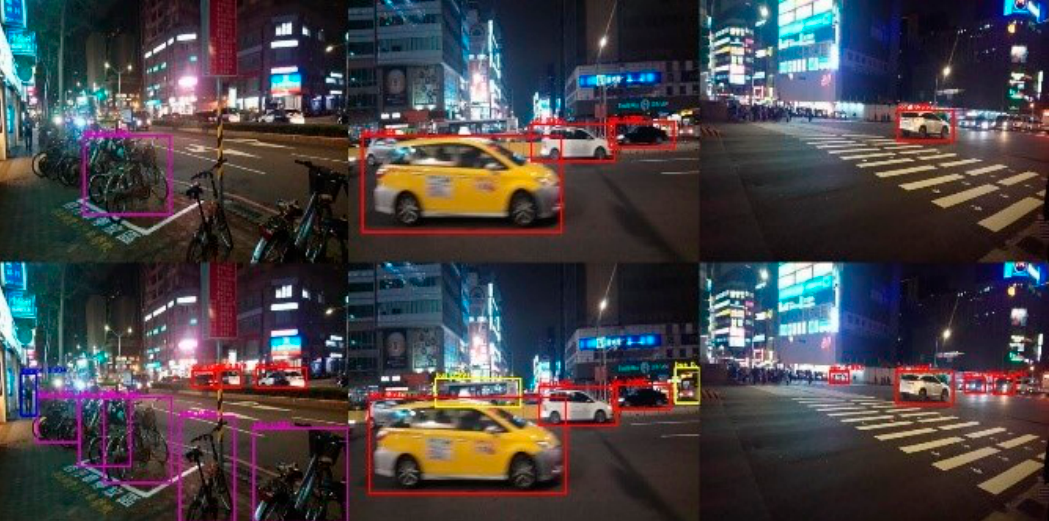
Figure 19. Outputs from two variants of the Faster R-CNN [5] with VGG16 [1]. Upper row: Ordinary model trained with PASCAL VOC 2007 [6]. Lower row: Proposed system trained with our nighttime data.